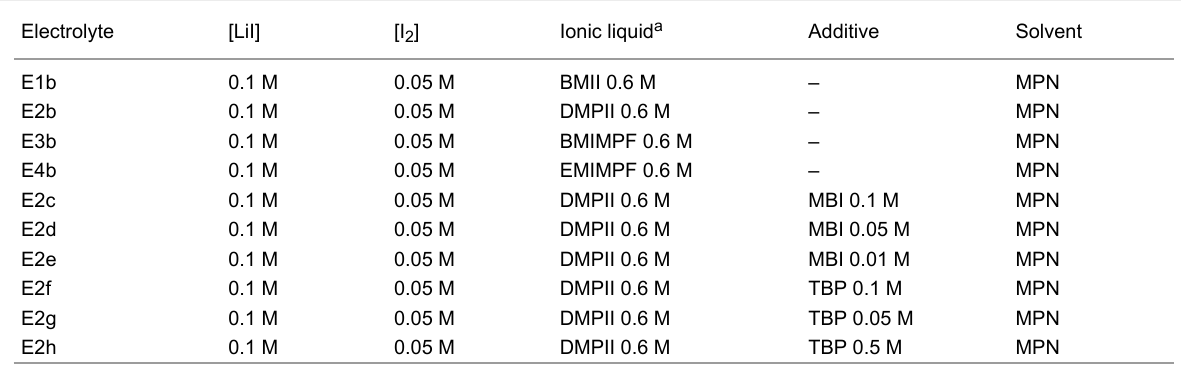
Table 3: Electrolyte compositions, showing the changes in additives in electrolytes E1–E4. Electrolyte